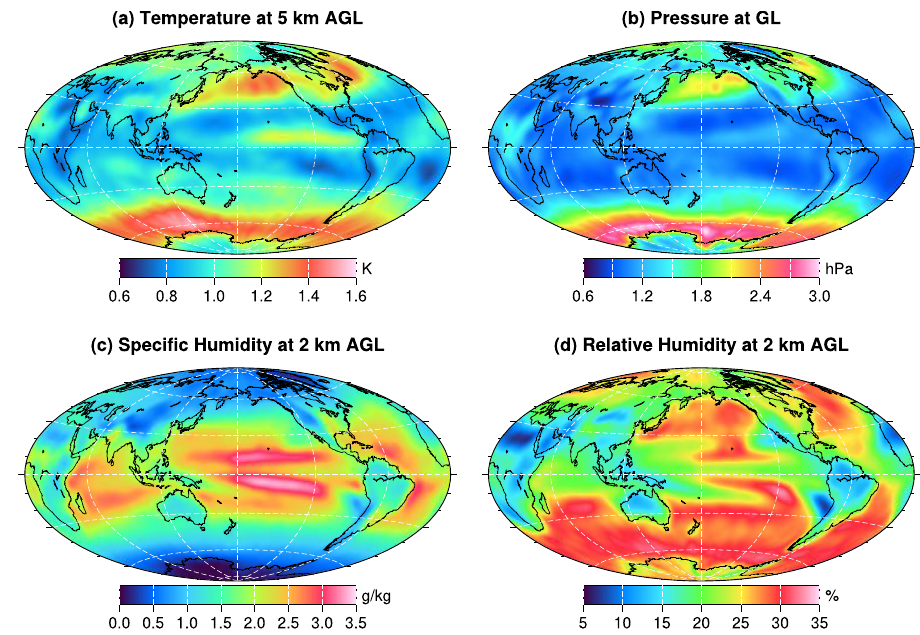
Figure 2. Horizontal view of annual-mean background error estimates: ( a ) temperature (°C) at 5 km above the ground level, ( b ) surface pressure (hPa), ( c ) 2 km specific humidity (g kg −1 ), and ( d ) 2 km relative humidity (%).